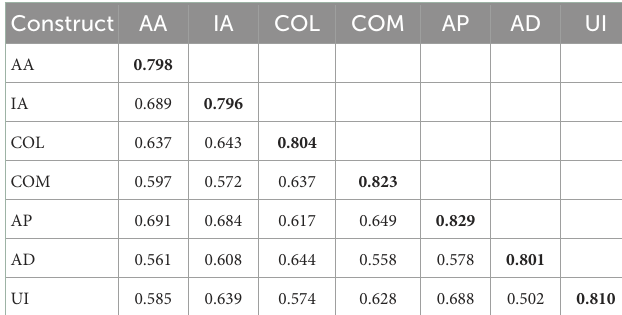
TABLE 4 Discriminant validity.